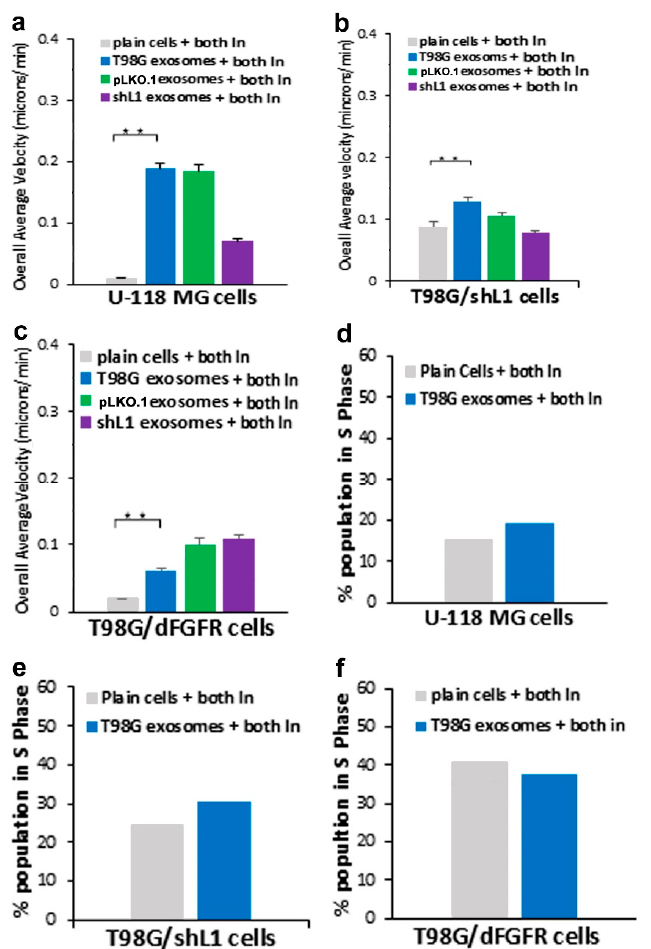
Figure 8. Effects of FGFR plus FAK inhibitors on motility and proliferation. ( a ) Overall average velocities of U-118 MG cells treated with both inhibitors, showing significant reduction in the migration rates with the inhibitors. ( b ) Overall average velocities of T98G / shL1 cells treated with both inhibitors. ( c ) Overall average velocities of T98G / dFGFR cells treated with both inhibitors. ( d ) U-118 MG cells had decreased proliferation (% S phase population) with the addition of both inhibitors. ( e ) T98G / shL1 cells treated with both inhibitors. ( f ) T98G / dFGFR cells treated with both inhibitors, ** p < 0.001.